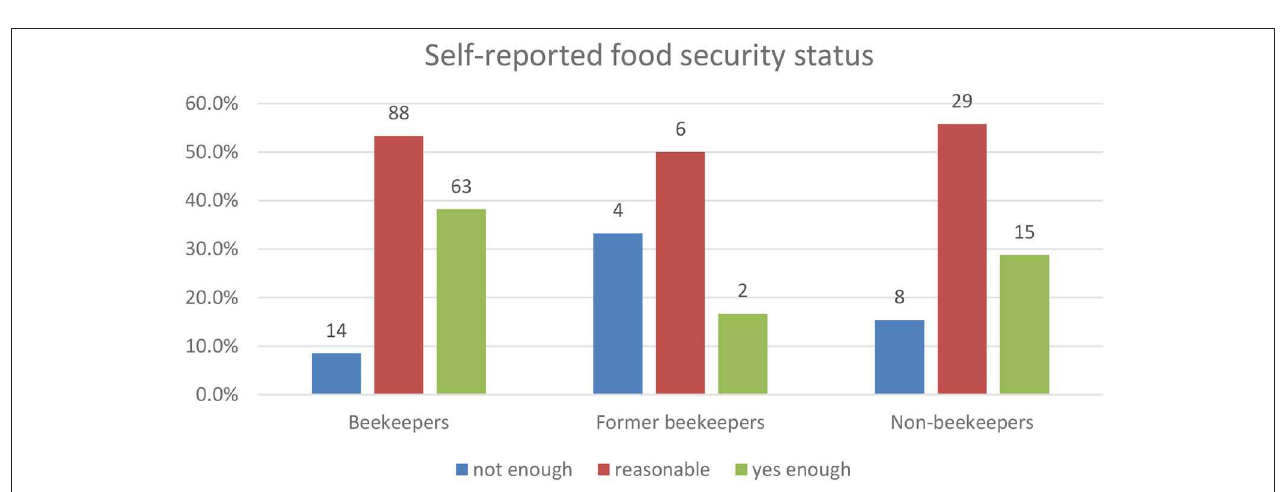
FIGURE 3 | Frequency (%) of responses about perception of own food security status. Source: Data collected from questionnaire survey in 2016.